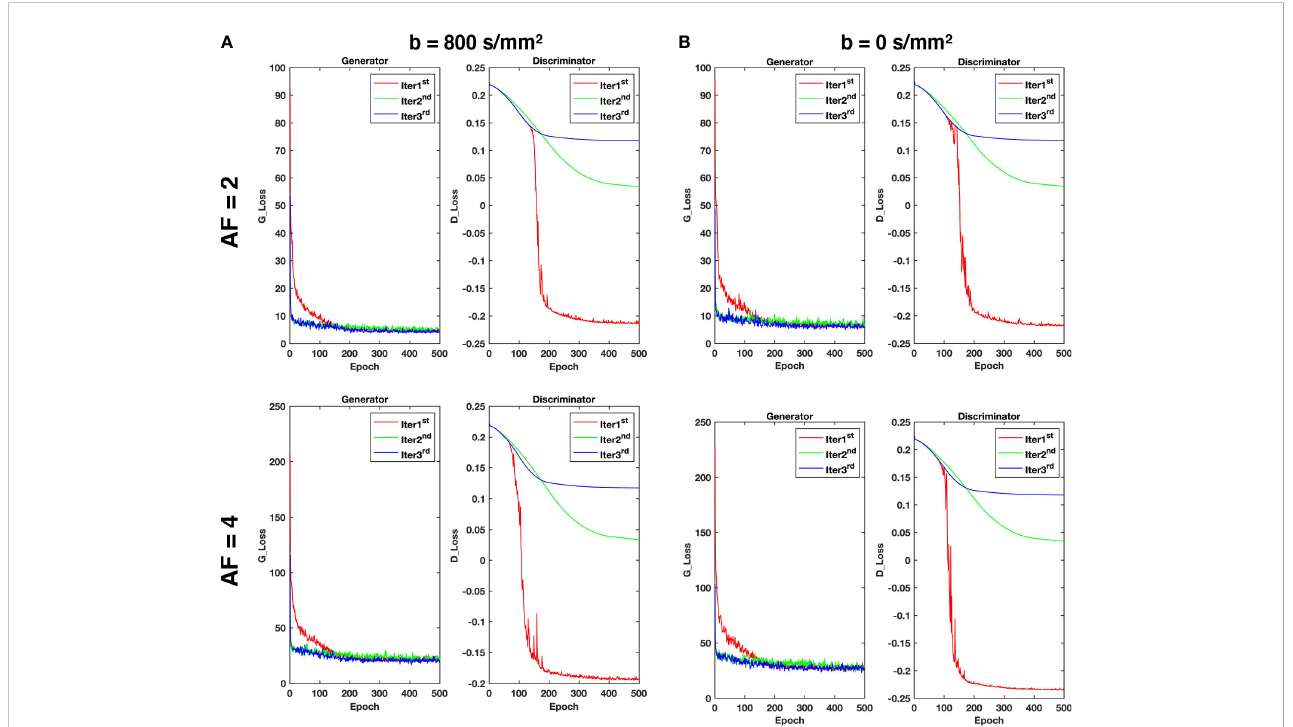
FIGURE 3 The loss curves of the generator and discriminator during training with different acceleration factors for (A) b = 800 s/mm 2 and (B) b = 0 s/mm 2